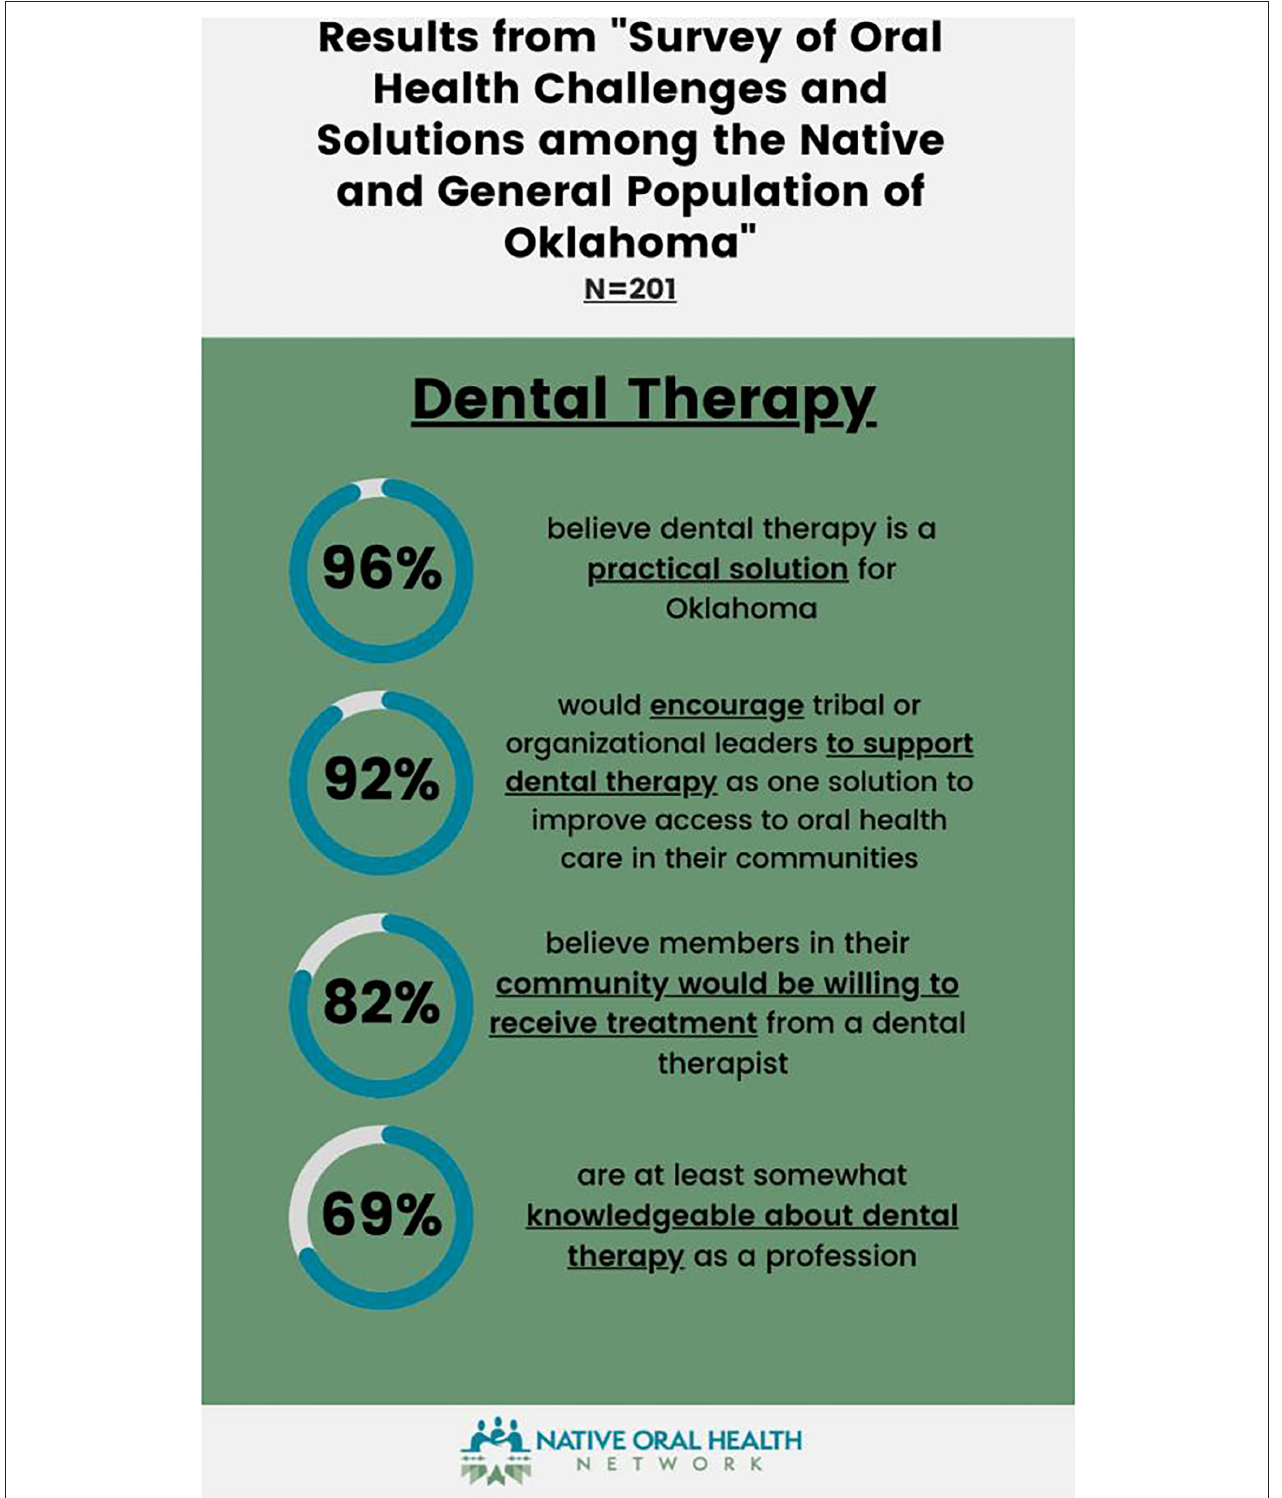
FIGURE 1 | Oral health challenges survey results. Image courtesy of the Native Oral Health Network.